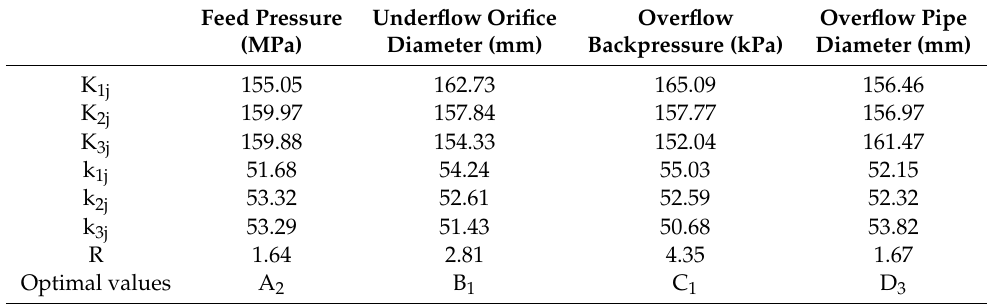
Table 12. Analysis of the orthogonal test data with the underflow concentration as the